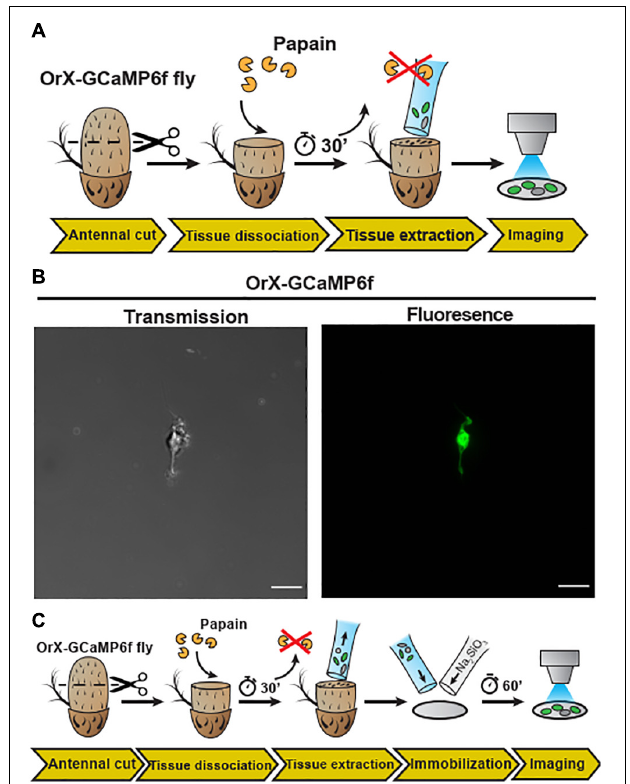
FIGURE 2 | Embedding of dissociated D. melanogaster antennal tissue in a sodium metasilicate gel. (A) Schematic procedure for dissociation and embedding of vinegar fly antennal tissue (see section “Materials and Methods”). After fixing the antenna with a silicon-based curing medium, the funiculus was cut and incubated with a papain solution for 30 min. Then, the dissociated tissue was extracted with a silanized glass capillary and then single neuron was extracted from this fly ( +; Orco-Gal4/CyO; UAS-Syn21-GFP-p10/TM6B ), using this preparation. (B) Confocal image of single cell as shown in transmission (gray) and fluorescence (green) signals, Scale bar = 8 µ m. In the next illustration (C) , after tissue extraction, the sample was mixed with a modified Drosophila Schneider’s medium containing 0.972% of a Na 2 SiO 3 stock solution ( ≥ 27% SiO 2 basis) on a methanol treated cover slip. Ca 2 + imaging was performed after a 60 min incubation time, to allow the Na 2 SiO 3